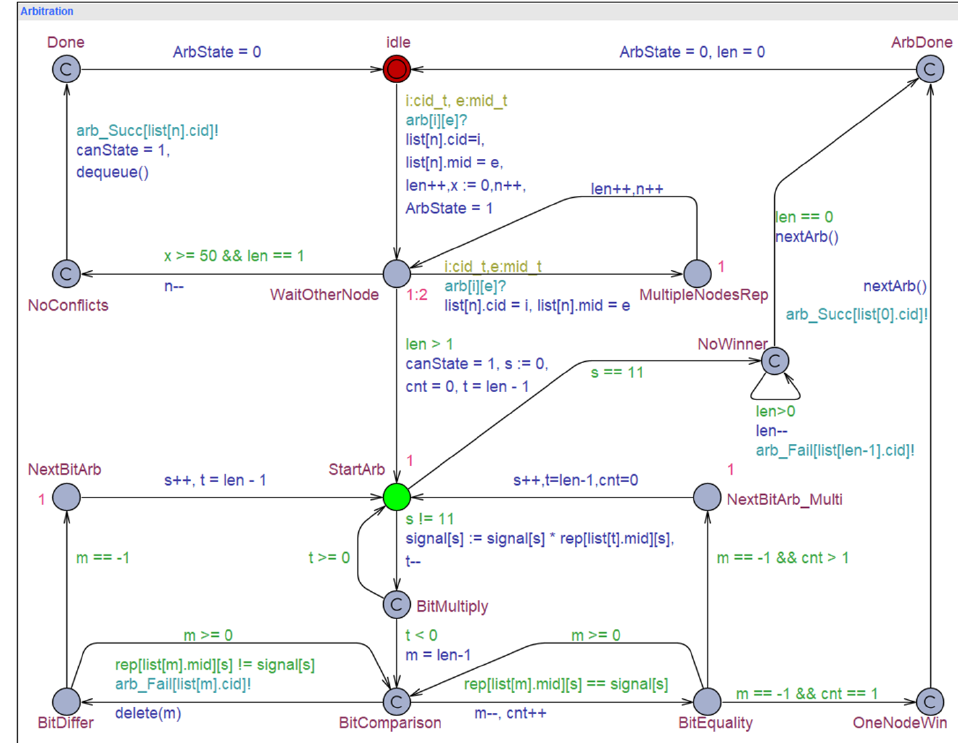
Table 3. Property verification formula and its description. Figure 9. TA of the arbitrator in the data link layer of CAN bus: Arbitration. Figure 9. TA of the arbitrator in the data link layer of CAN bus: Arbitration.